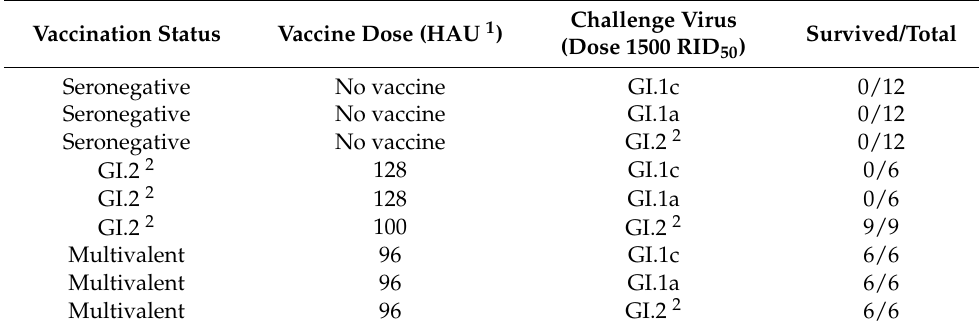
Table 2. Proportion of vaccinated rabbits that succumbed to rabbit hemorrhagic disease following oral inoculation with Australian lagoviruses.